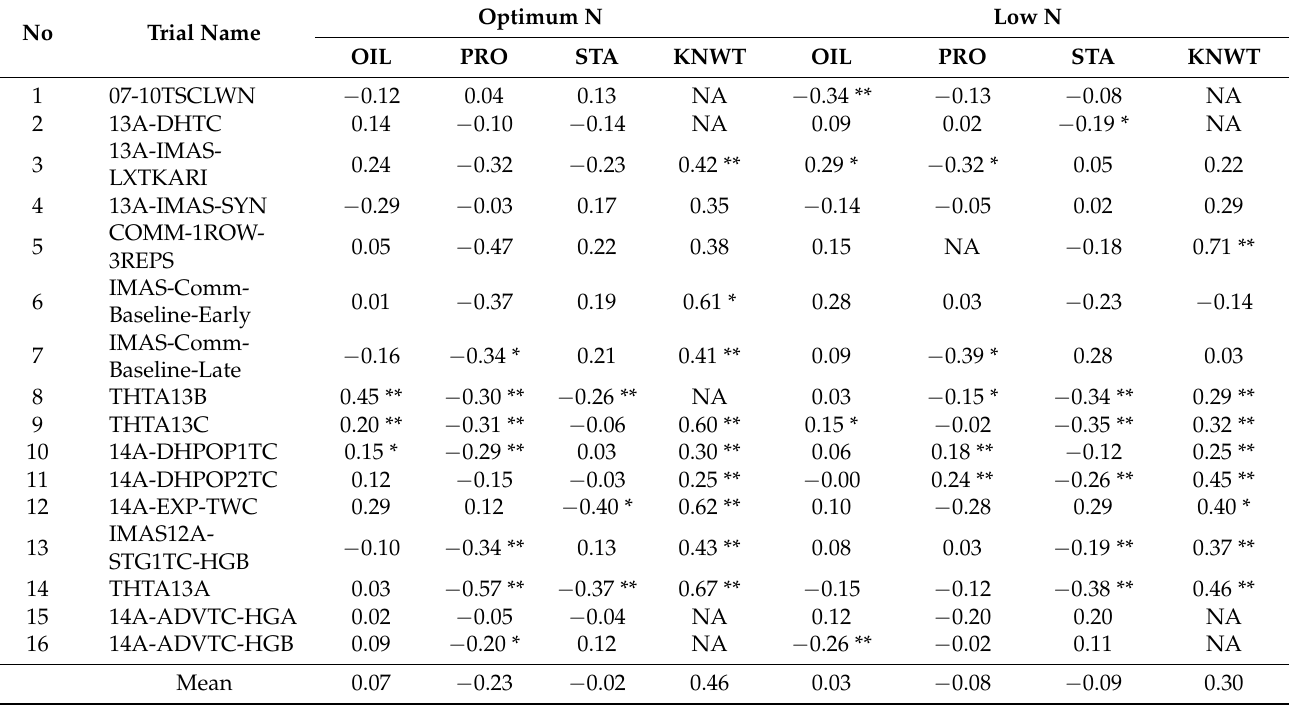
Table 3. Pearson correlation between grain yield and grain quality parameters (oil, starch, protein) and Kernel weight under optimum and low N in 16 trials evaluated in Kiboko, Kenya from 2011 to